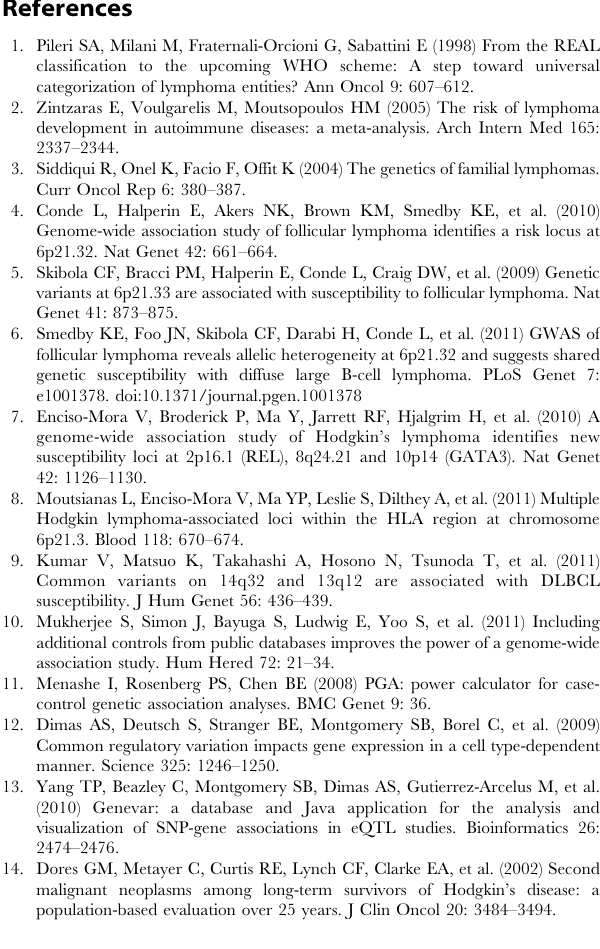
Table S3 Correlation and recombination rate of SNPs associ- ated with the HLA and 11q12.1 regions in HapMap. Table S4 Sample sizes in Stage-1 and Stage-2. The samples for the phase 1 were collected at MSKCC (N= 860), Dana Farber Cancer Institute (N =74) and Hadassah Hebrew University, Israel (N = 10). The replication phase was ascertained at